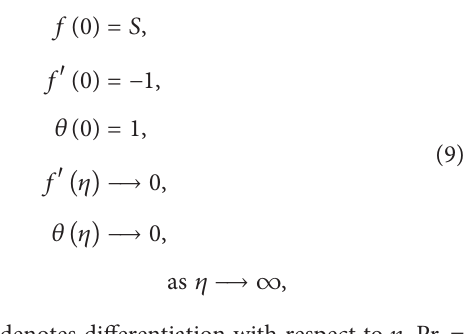
Figure 1: Sketch of the physical flow